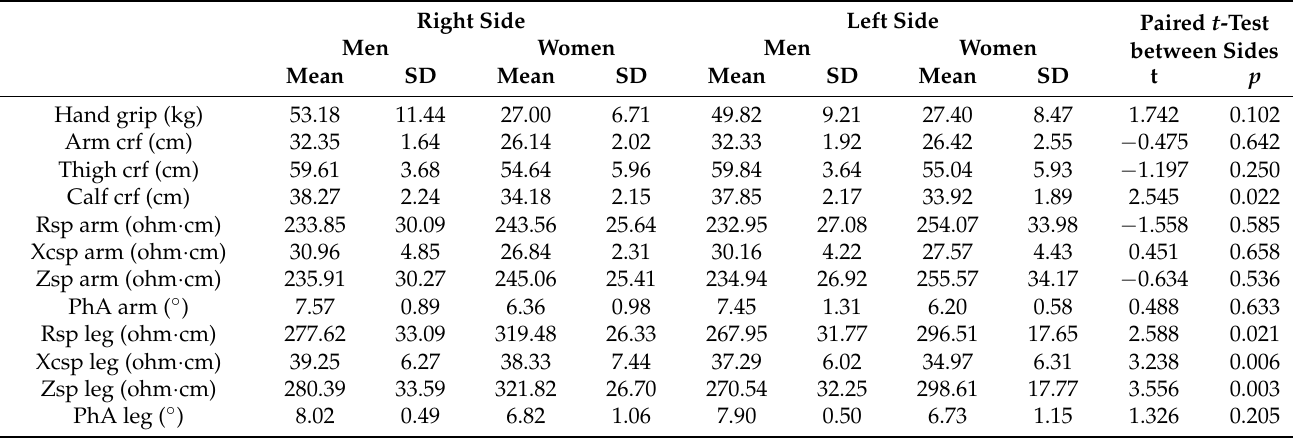
Table 2. Laterality of strength, anthropometrical, and bioelectrical variables. Right